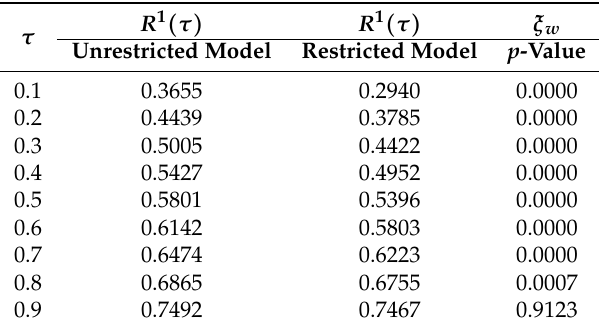
Table 2. Restricted model against unrestricted